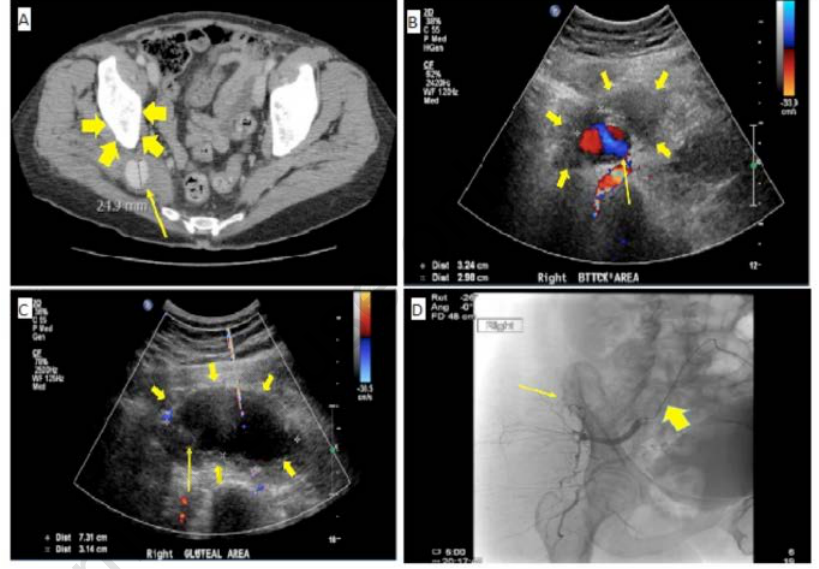
Figure 1. A). Case 1. Pelvic CT with IV contrast on Day 9 after bone marrow procedure (BMP) on the right posterior superior iliac spine (PSIS). Probable pseudoaneurysm (PSA) of the right gluteal artery (arrow) was demonstrated immediately adjacent to the PSIS (arrowheads) measuring 2.5 × 2.4 × 2.4 cm. (B) Case 1. Color Doppler ultrasound of the right gluteal area on Day 11 after BMP on the right PSIS. A 3 cm pulsatile vascular sac with alternating flow was demonstrated in the neck of the sac (arrow). Inferior to this PSA, an actively bleeding vessel was seen. Surrounding the PSA, an irregular hematoma, measuring 10.2 x 5.3 cm was noted (arrowheads). (C) Case 1. Color Doppler ultrasound of the right gluteal area on Day 43 after BMP (29 days after thrombin injection). The PSA has completely resolved (arrow). The hematoma and/or organizing thrombus persist, but are smaller, measuring 7.3 × 3.1 cm (arrowheads). (D) Pelvic arteriogram on Day 10 after BMP of Case 2. The catheter is seen in the right internal iliac artery (arrowheads). Catheter advancement revealed no active bleeding and a small PSA is seen